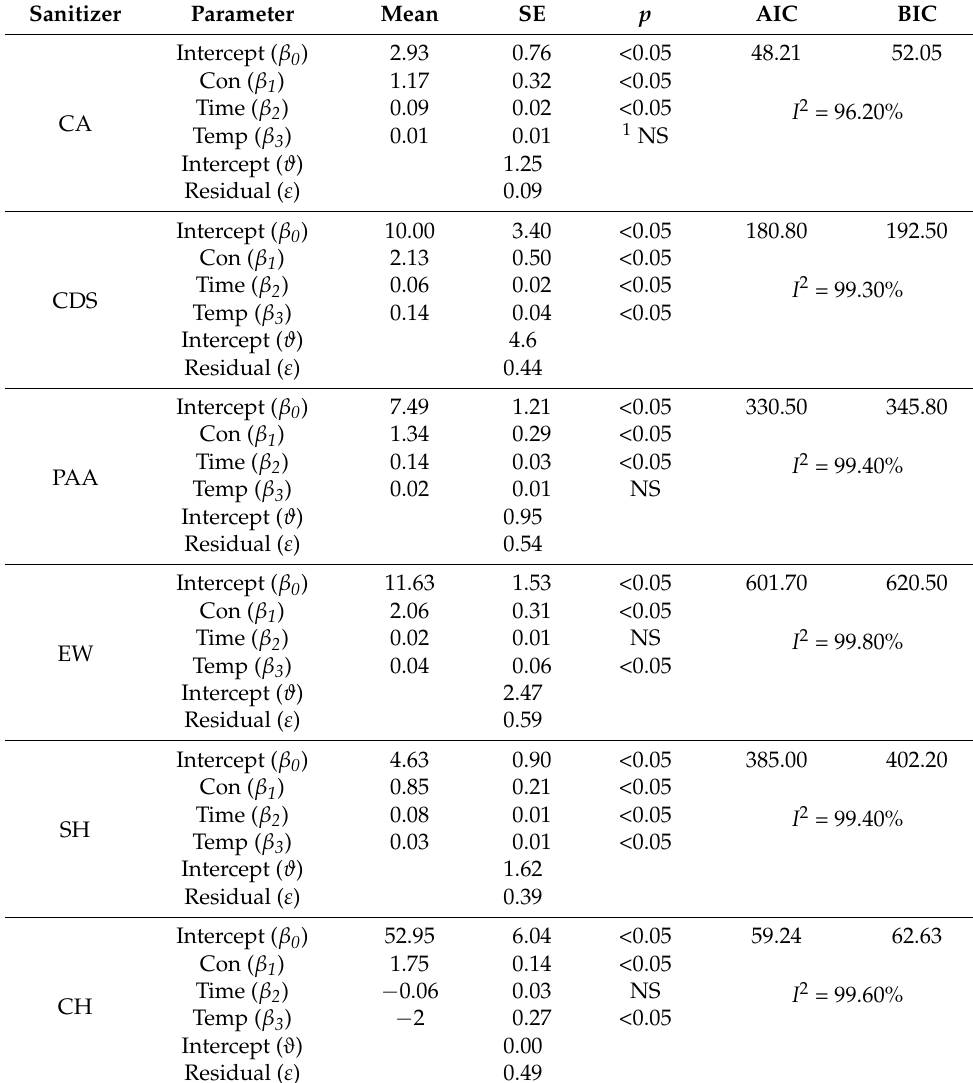
Table 1. Estimated parameters of the mixed-effects models by